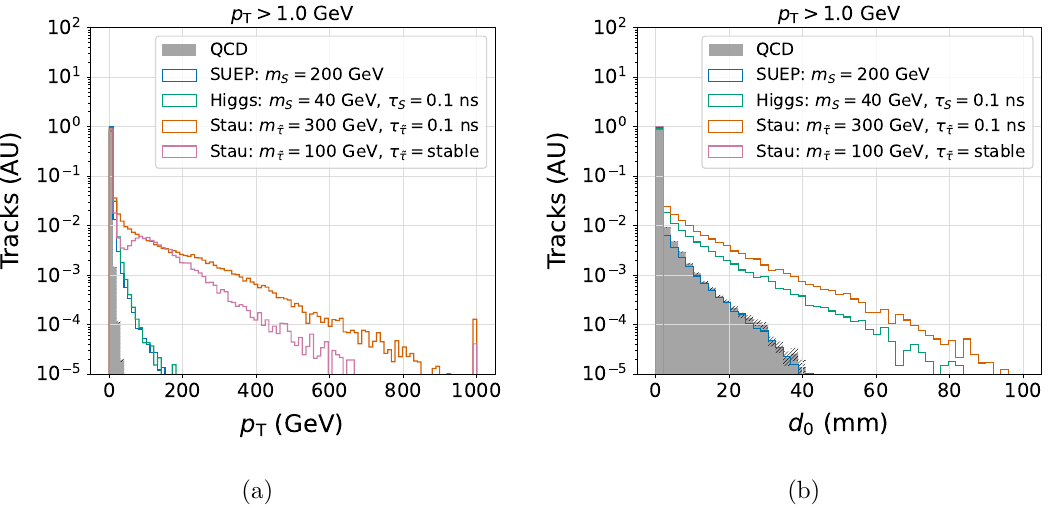
Figure 20. Track p T (a) and | d 0 | (b) for QCD and representative signal samples.